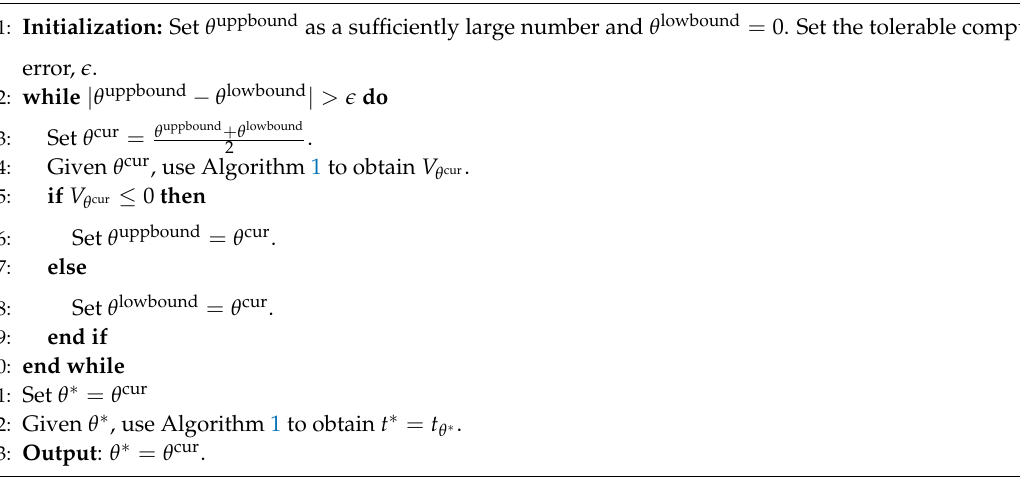
Algorithm 2 To solve Problem (P2-Top) and find θ ∗